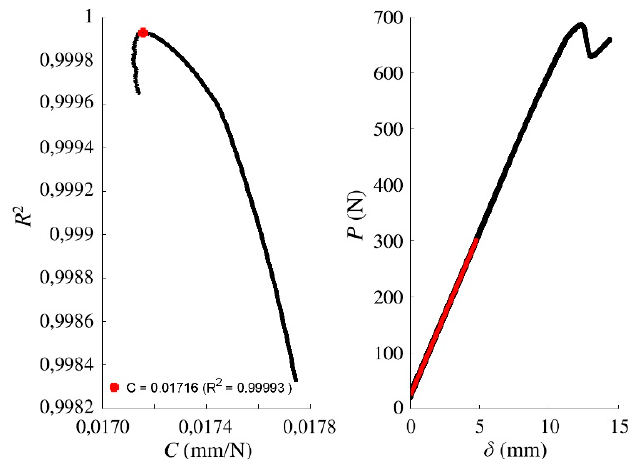
Figure 4. Example of initial compliance determination for a load–displacement curve from an ENF test (specimen “176-3”): (Left) compliance– R 2 relationship (red point indicates the compliance with maximum R 2 ); and (right) load–displacement curve with the compliance highlighted in red.